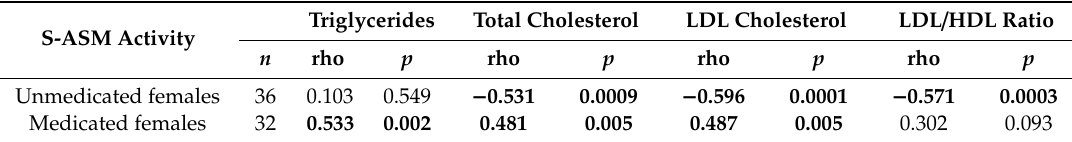
Table 4. Opposite correlation of serum acid sphingomyelinase (S-ASM) activity with serum lipids in female unmedicated and medicated depressive patients with a current major depressive episode.